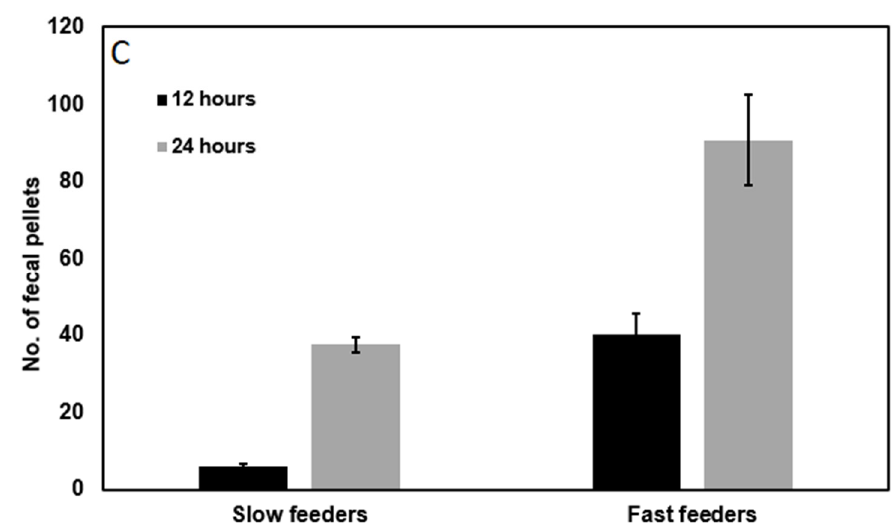
Figure 2. ( A ) Fecal production rate per neonate at 25 ◦ C during their first 12 h as a larva versus their feeding rate during the next 24 h for Cry1Ac-susceptible Helicoverpa zea from a standard lab strain on artificial diet without Bt (in the feeding disruption assay). The data were organized on the X-axis based on increasing number of fecal pellets produced in the first 12 h for individual neonates and the corresponding fecal pellets produced from the same insect in the following 24 h plotted directly above (n = 38). ( B ) Percentage of larvae in ( A ) that were slow feeders (produced 1–15 fecal pellets) versus fast feeders (produced 30–50 fecal pellets) in the first 12 h. ( C ) The rate of feeding based on the number of fecal pellets produced in the first 12 h was used to sort larvae as slow and fast feeders and successfully predicted slow and fast feeders over the next 24 h. Error bars are ±1 standard error of the mean.